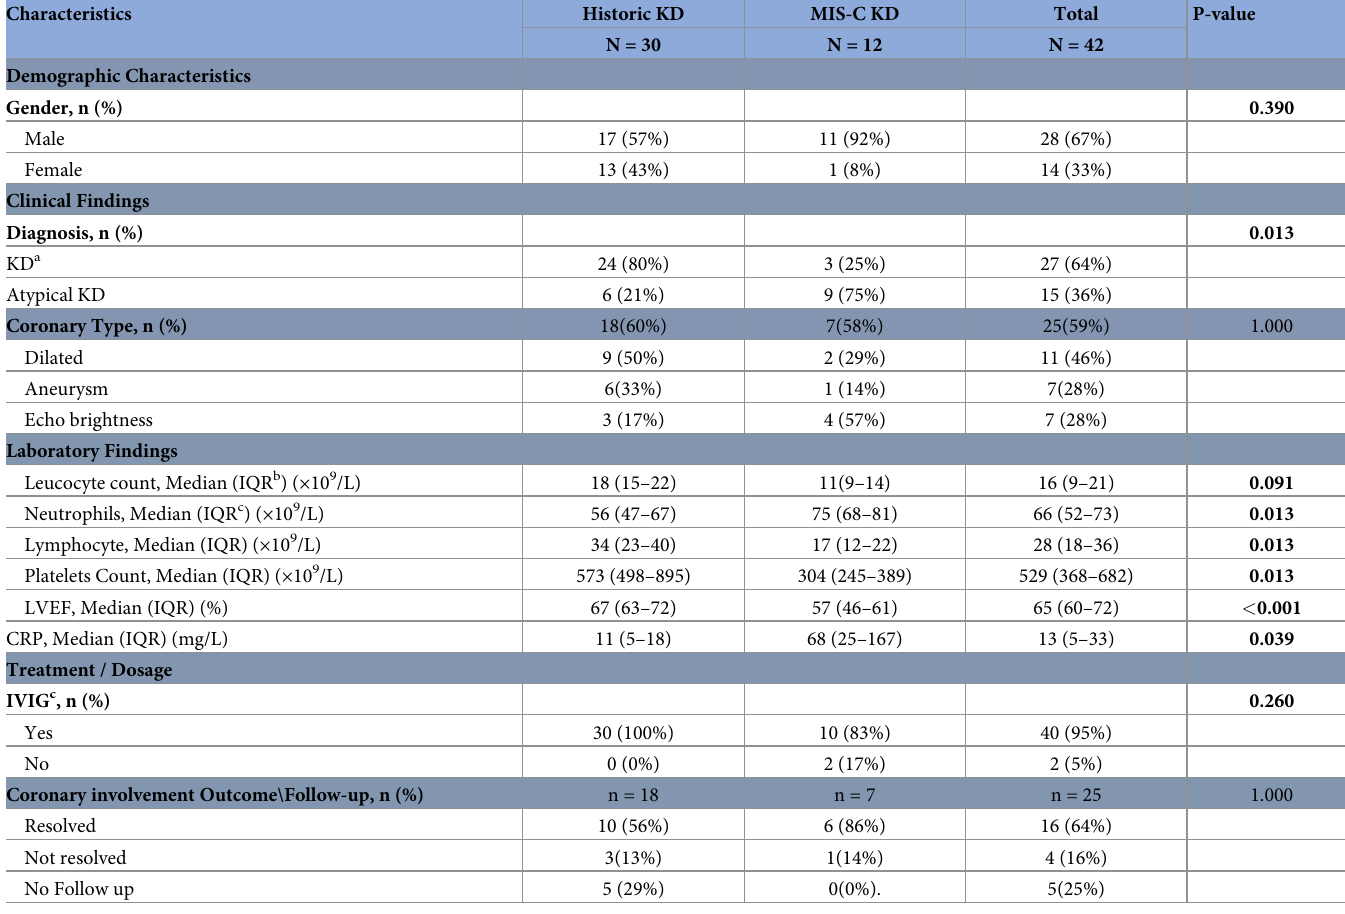
Table 3. Comparison of clinical and laboratory characteristics of historic and MIS-C Kawasaki